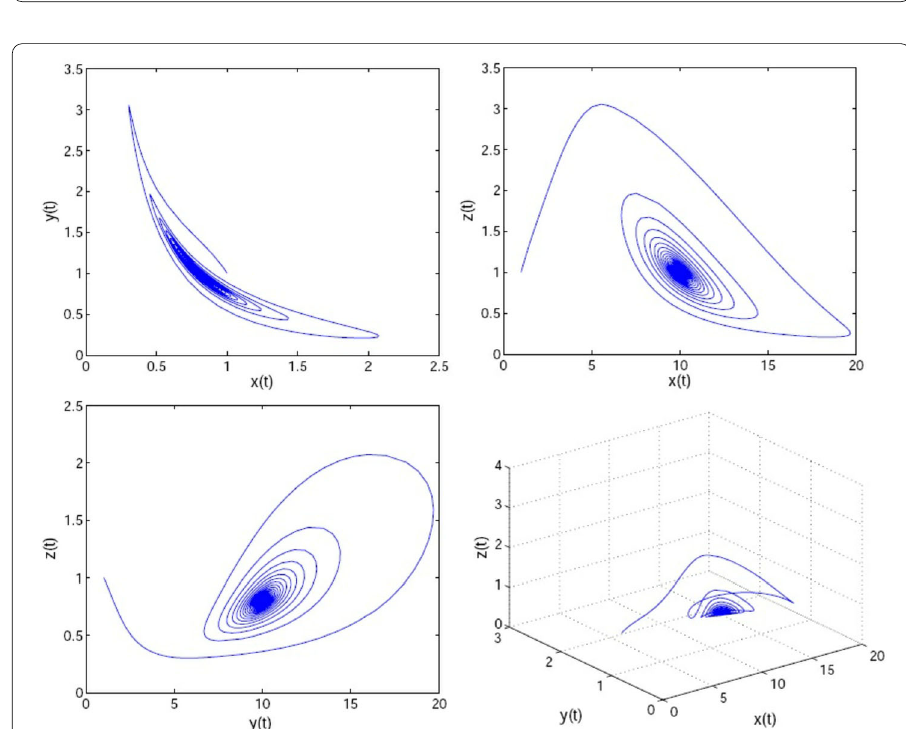
Figure 2 The phase plots of system (31). It is asymptotically stable when τ = 6.6 < τ 0 =